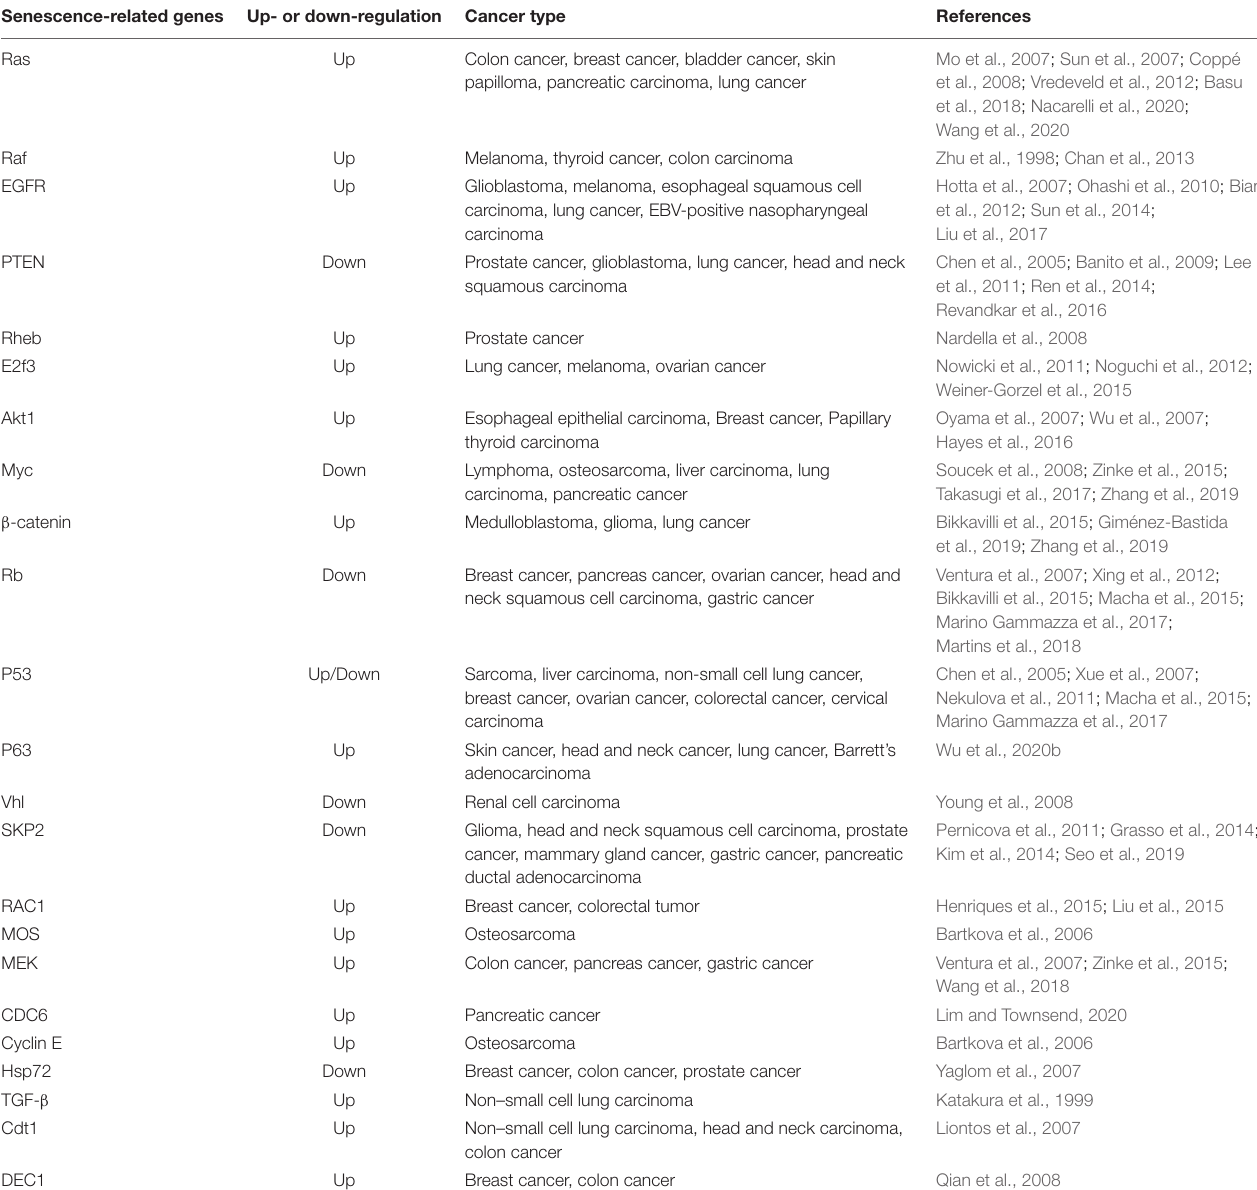
TABLE 1 | Cellular senescence-related